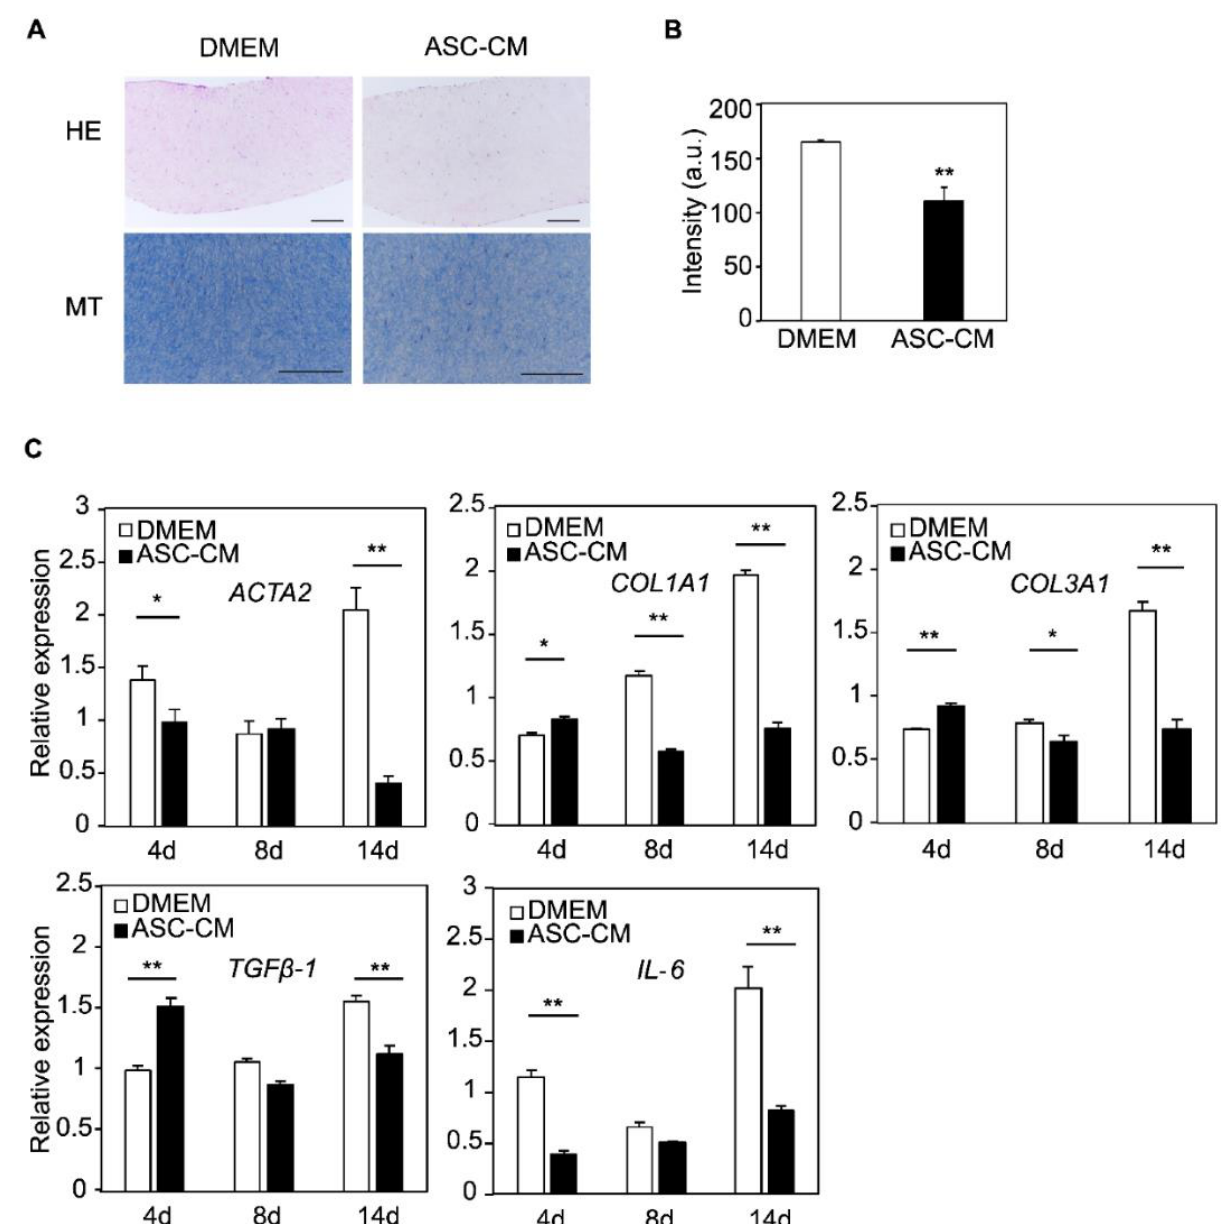
Figure 5. ASC-CM suppressed collagen aggregation and gene expressional changes in KF discs. ( A ) Representative images of hematoxylin and eosin- stained and Masson’s Trichrome -stained KF discs sections are shown. All bars indicate 200 μm. ( B ) Staining density of collagen fibers in KF disks. Results are presented as the mean ± standard deviation of three biological replicates. ** p < 0.01, unpaired Student’s t -test. ( C ) Gene expression analysis of scar markers in KF discs treated with DMEM or ASC-CM. Results are shown as relative gene expression on day 0. Results are presented as the mean ± standard deviation of three biological replicates. * p < 0.05, ** p < 0.01, unpaired Stu- dent’s t -test. Abbreviations: ASC-CM, conditioned media derived from adipose stem cells; KF, ke- loid fibroblasts; DMEM, Dulbecco’s modified Eagle’s medium; HE, hematoxylin and eosin; MT, Masson’s Trichrome.